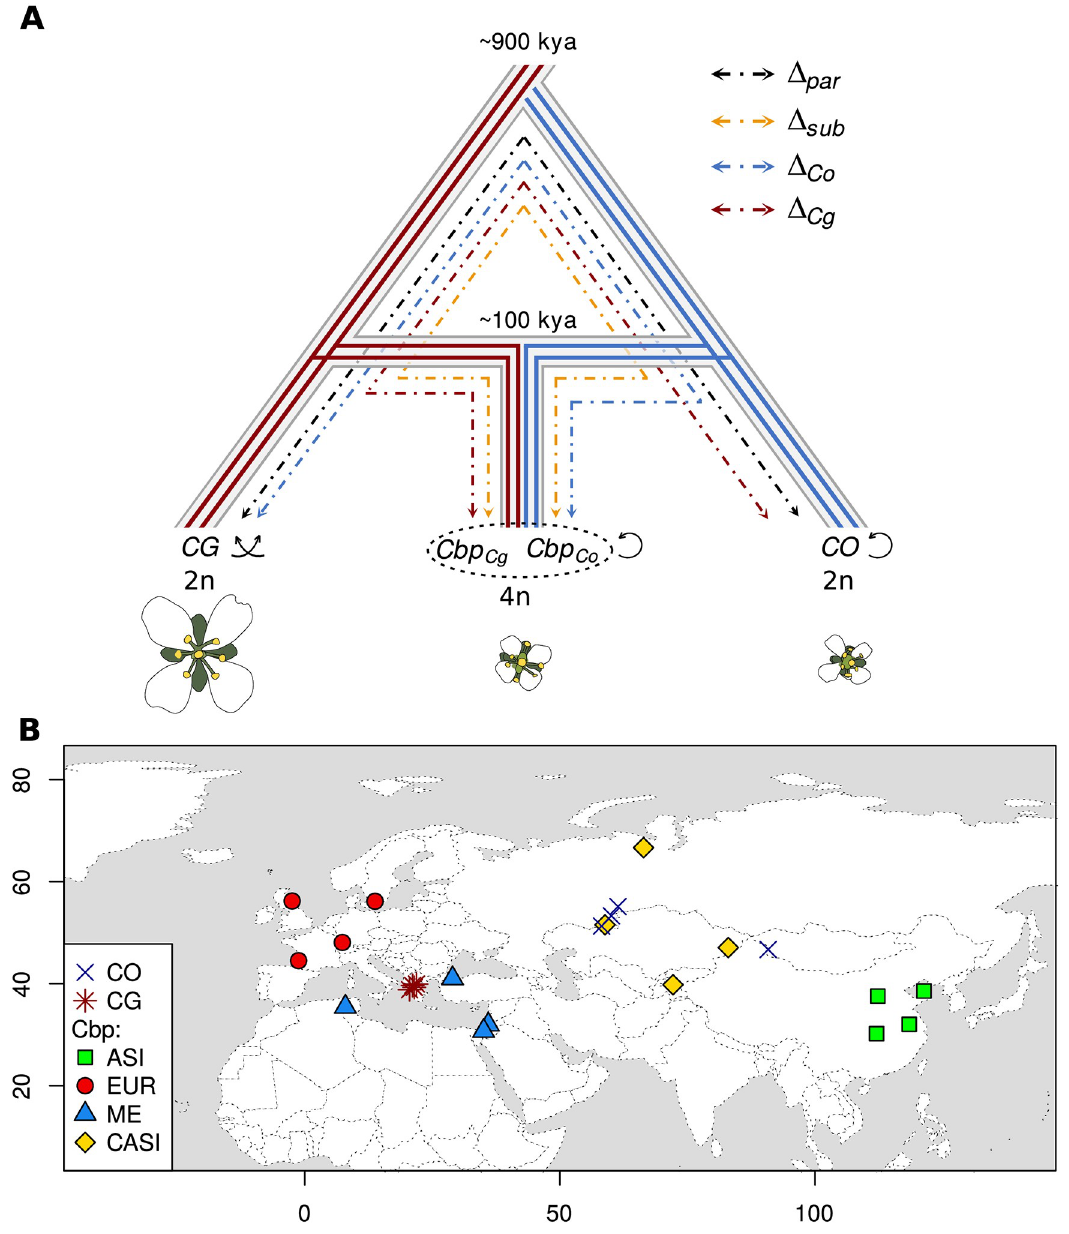
Fig 1. Evolutionary history and sampling locations of the three Capsella species used in this study. A Solid lines represent subgenomes segregation after the hybridization between C. grandiflora ( CG ) and C. orientalis ( CO ) ancestors. C. grandiflora and C. orientalis genetic backgrounds are marked with red and blue respectively. The ploidy levels (n) and the reproductive system are also indicated. Dashed and dotted lines represent the comparisons used to compute the gene expression convergence index (see Material and methods). B . CO, CG, ASI, EUR, ME, CASI correspond to C. orientalis , C. grandiflora , and four populations of C. bursa-pastoris , Cbp , (Asia, Europe, Middle East, and Central Asia) respectively. We shifted slightly population geographical coordinates when those overlapped to make all of them visible on the map.